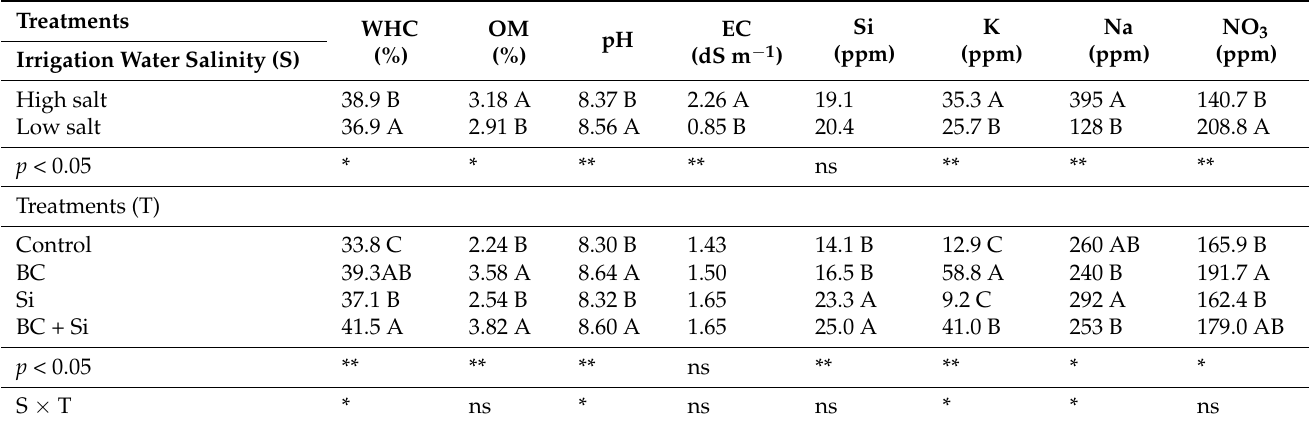
Table 3. Soil nutrient values and significance levels for Experiment